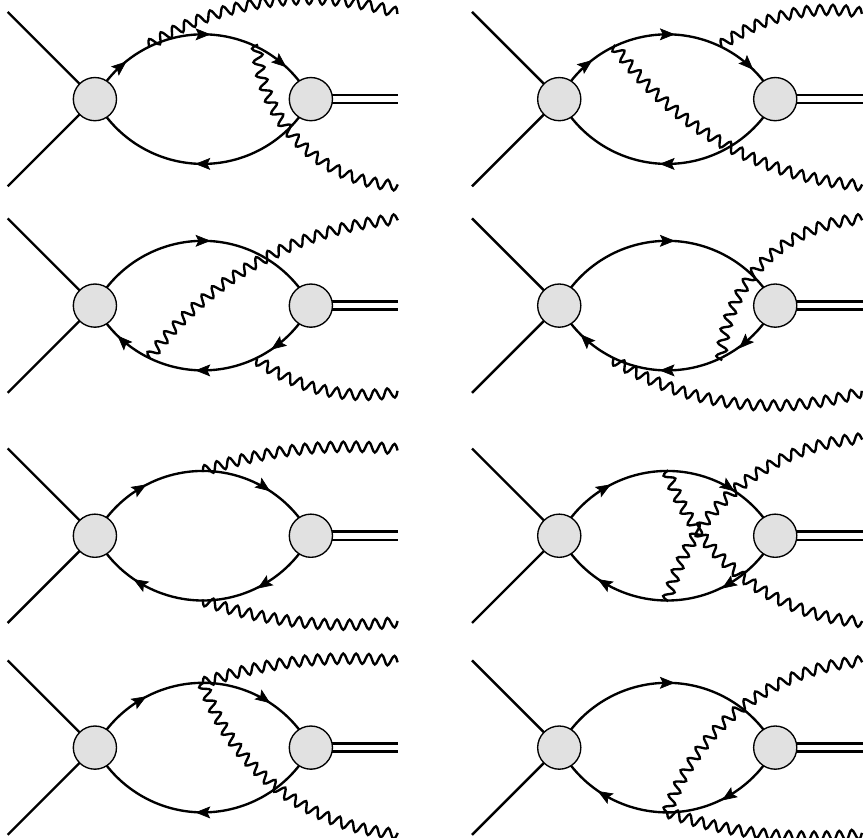
Figure 21 . Diagrams for w 0 w 0 ! ( ww )+ (cid:13)(cid:13) in which the two photons are attached to charged-wino lines in the same